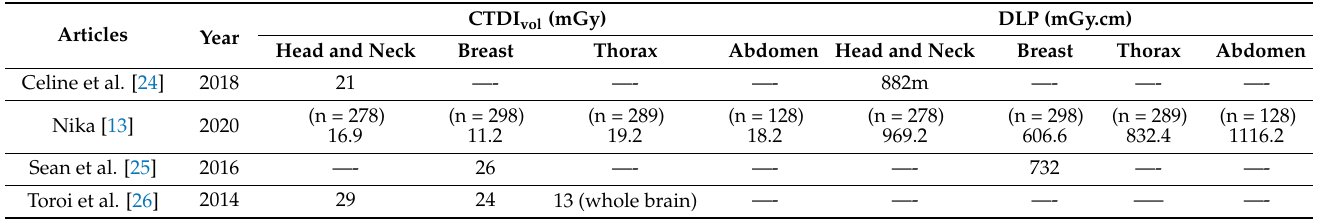
Table 4. DRLs for Head and Neck, Breast, Thorax, and Abdomen based on CTDI vol and DLP